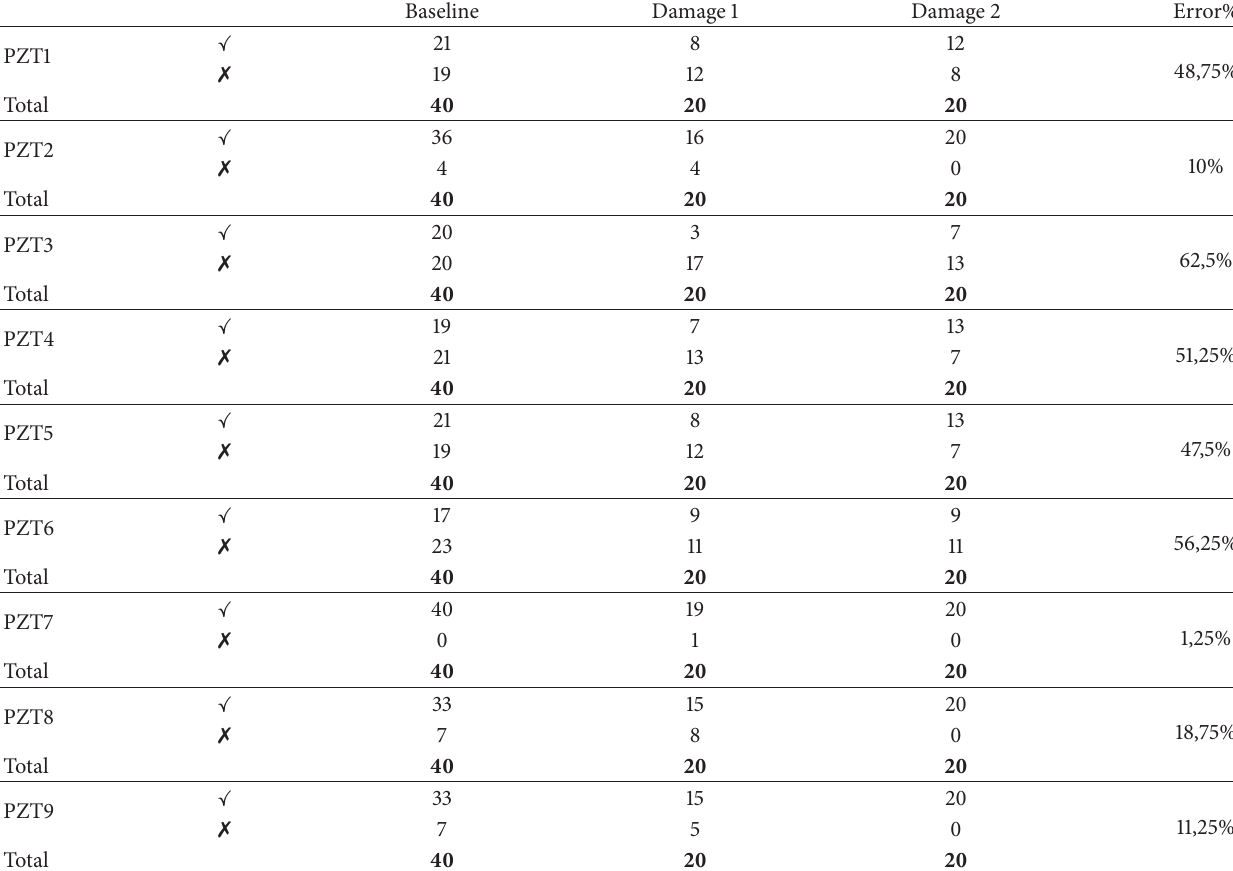
Table 6: Classification of test set of probabilistic neural networks for each PZT patch of the aircraft window.